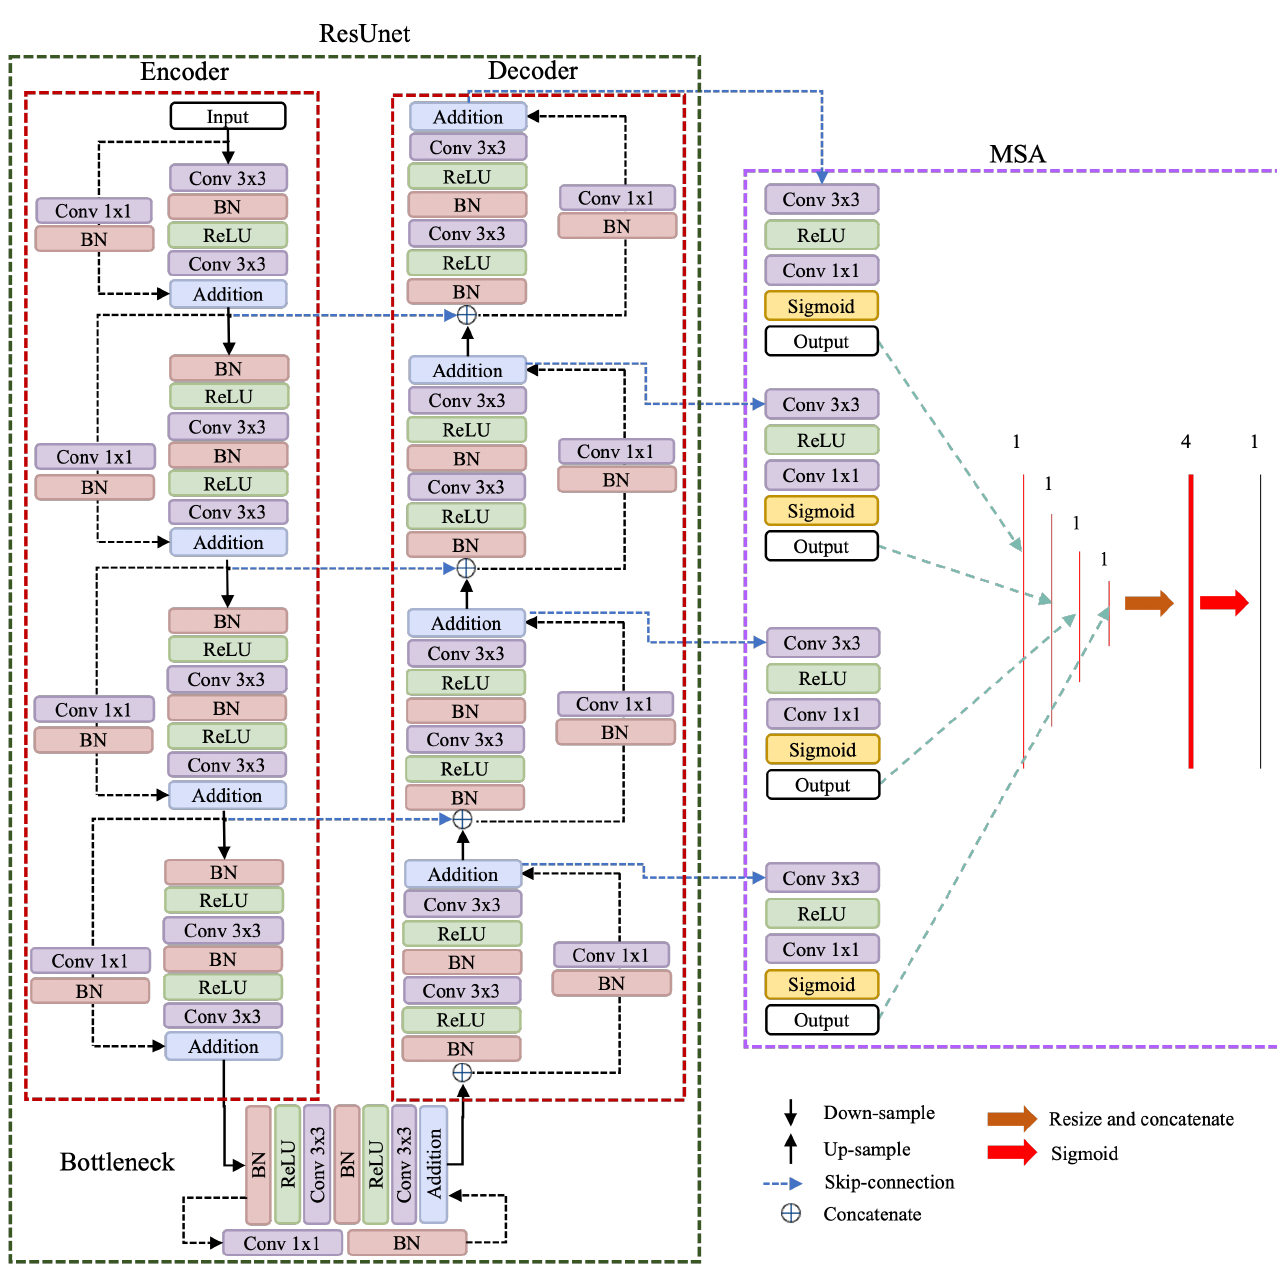
Figure 4. Network architecture of the proposed MSA-ResUNET. The encoder, bottleneck, and skip connections bring the knowledge derived from rich multi-scale feature maps to the decoder of the ResUNET [4]. The MSA-block of the proposed MSA-ResUNET inherits these multi-scale features from all four decoder blocks and applies 3 × 3 convolutions with ReLU activation function followed by a 1 × 1 convolution with sigmoid function to produce a segmented map. The maps of all four scales are then aggregated by (i) re-sizing them to input image size; (ii) concatenating together; and (iii) applying a 1 × 1 convolution with a sigmoid activation function to obtain the final